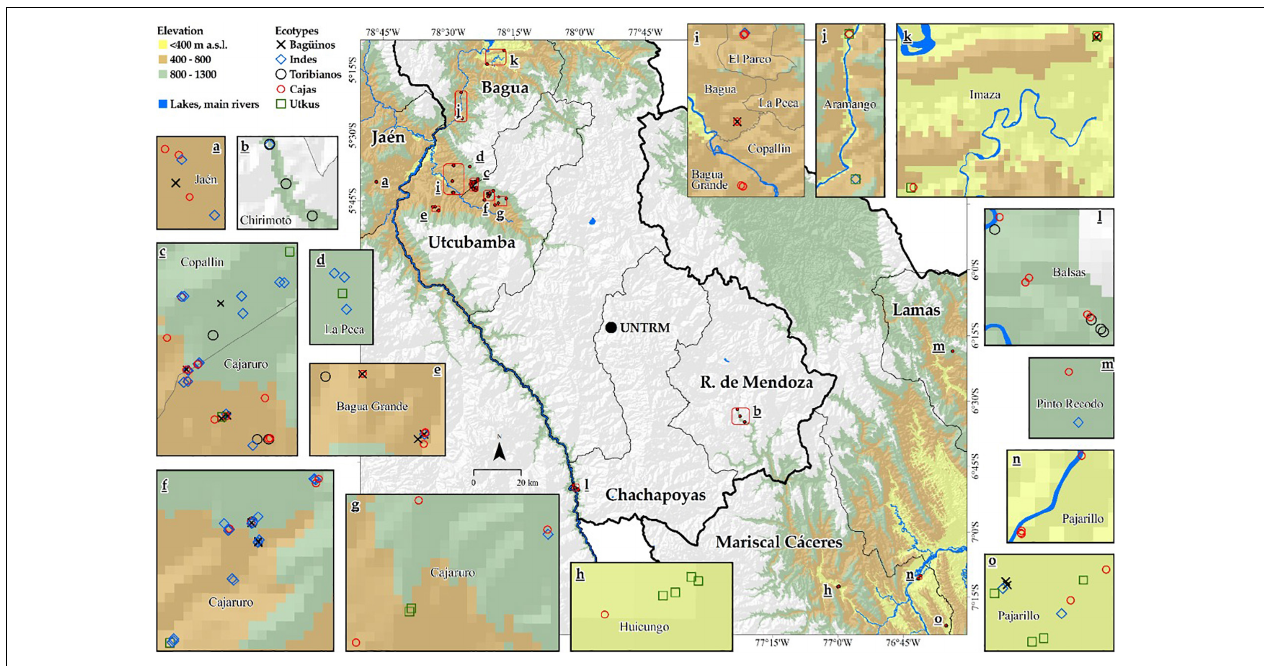
FIGURE 6 | Distribution map of FFNC genetic groups.